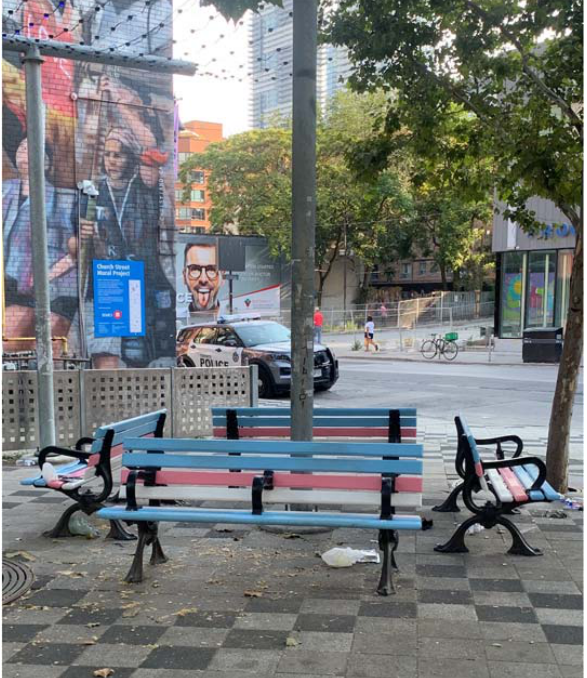
Figure 2. Trans flag benches located in Barbara Hall Park. A police cruiser can be seen parked on the perimeter of the park.